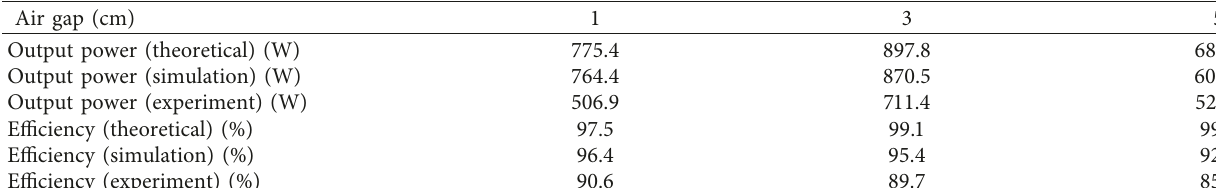
Table 6: Output performance of the system under different air gaps.